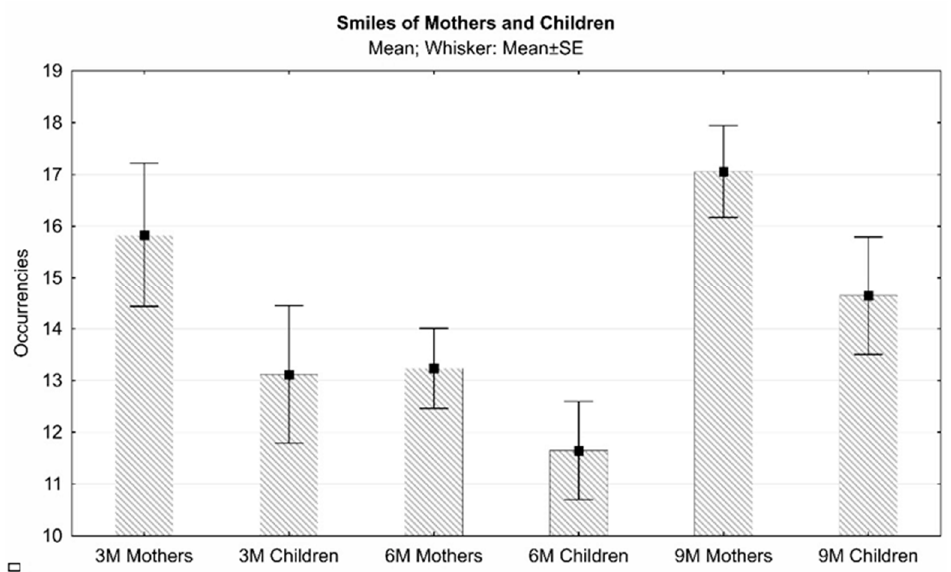
Figure 4. Mean and standard error of occurrences of maternal and infant smiles at three, six, and nine months.